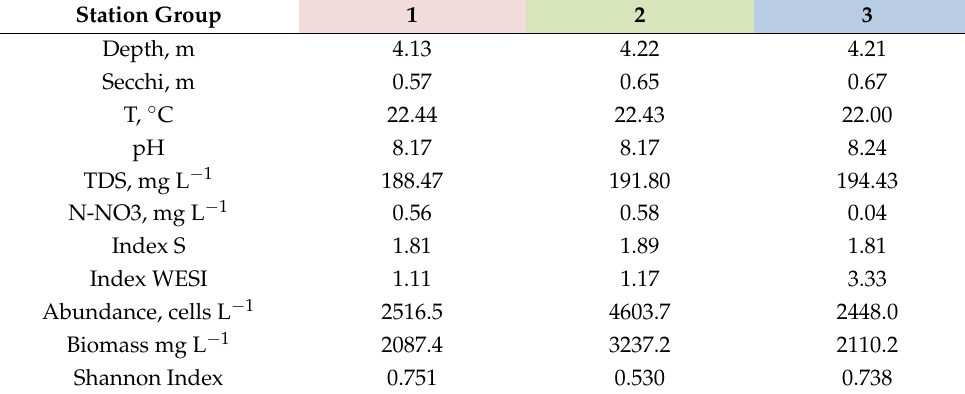
Table 2. Distribution of averaged environmental and biological variables of phytoplankton over groups of stations in Figure